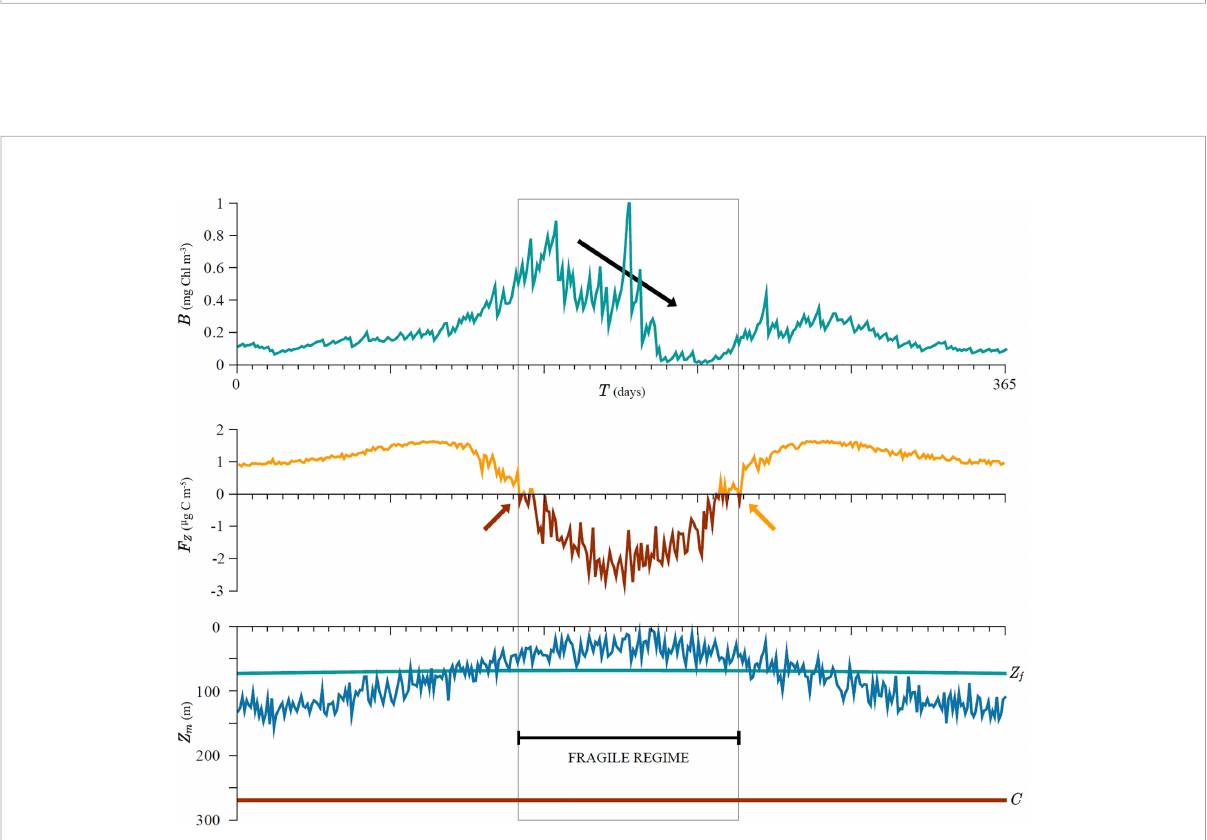
FIGURE 7 Simulated seasonal cycle of biomass, mixed layer depth and the resulting fragility. The seasonal cycle in biomass becomes distorted as soon as the mixed-layer depth (blue curve) crosses the fragility depth (green line). The distortion is noticed as a sharp drop in biomass over time (black arrow) which lasts until the system remains in the fragile state (grey area). Although the variability in mixed layer depth is constant over time it is ampli fi ed during the fragility regime and losses from dilution are harder to compensate by increased production from subsequent shallowing. The start and end of the fragility regime are correctly predicted as F Z becomes negative and vice versa (orange and red curves/arrows). The critical depth C (red line) is deeper than the mixed-layer depth Z m (blue curve) during the entire simulation, therefore the critical depth criterion is satis fi ed. See Supplementary material for more